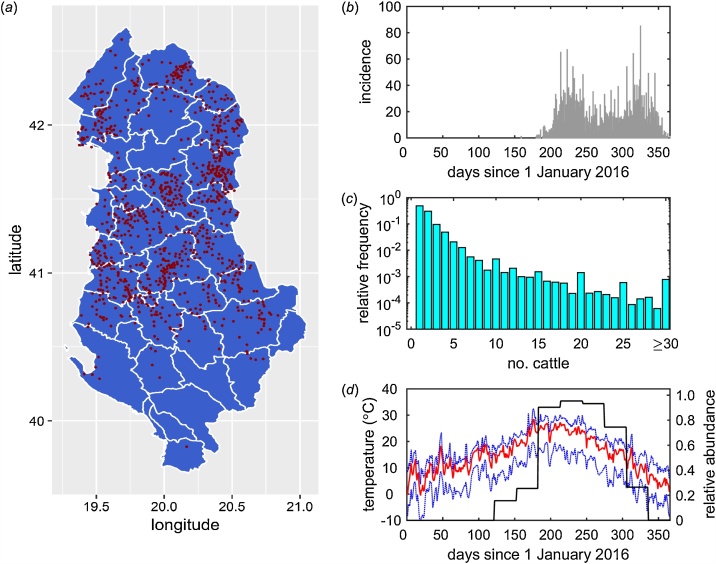
Data used when analysing transmission of lumpy skin disease virus (LSDV) between herds in Albania in 2016. (a) Location of reported outbreaks of LSDV. Note that locations are to village level and villages may have had multiple outbreaks. (b) Daily incidence of newly reported herds. (c) Herd size distribution. (d) Median (red line), minimum and maximum (blue dashed lines) daily mean temperatures and mean simulated relative abundance of Stomoxys calcitrans, a putative vector of LSDV (black line). (For interpretation of the references to colour in this figure legend, the reader is referred to the web version of this article).